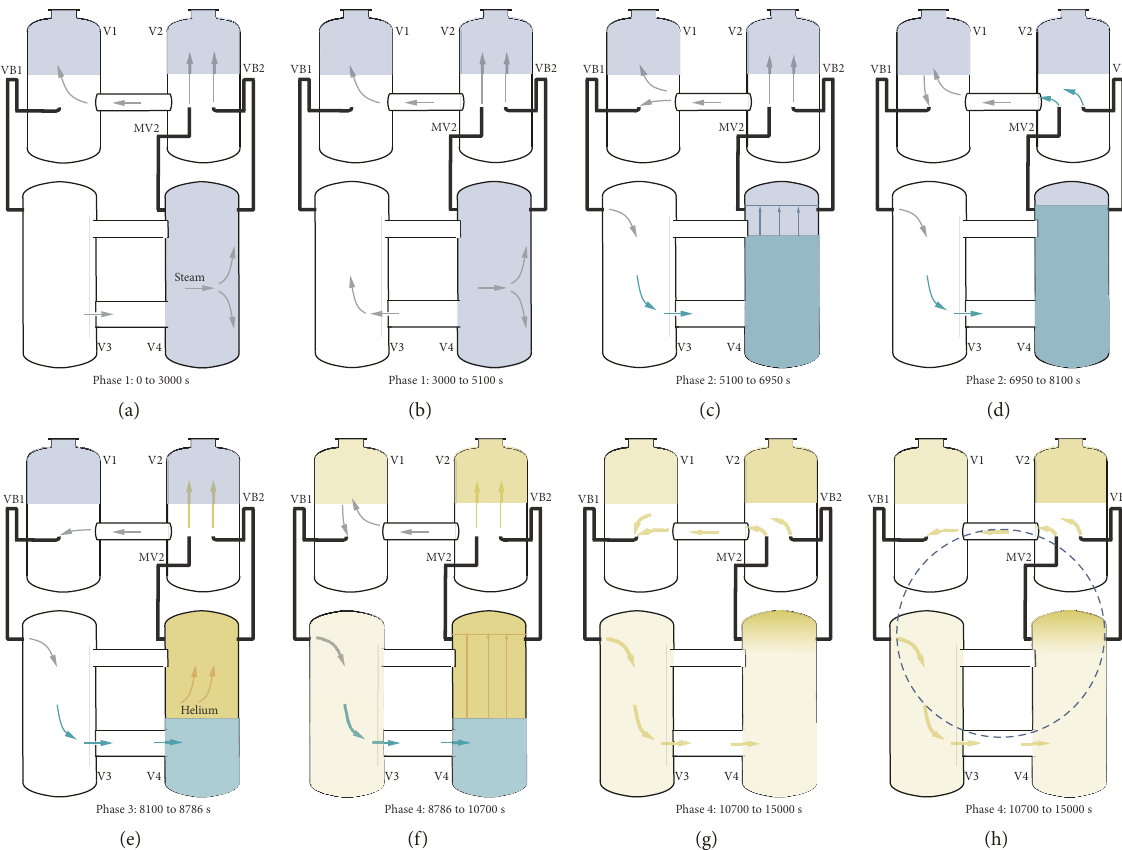
Figure 8: Global flow structures and phenomena in all four vessels during all phases of the experiment HP6